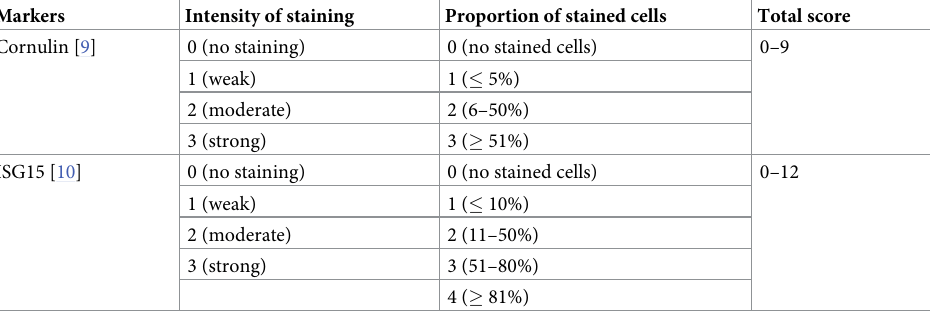
Table 1. Immunohistochemical scoring method for Cornulin and ISG15.